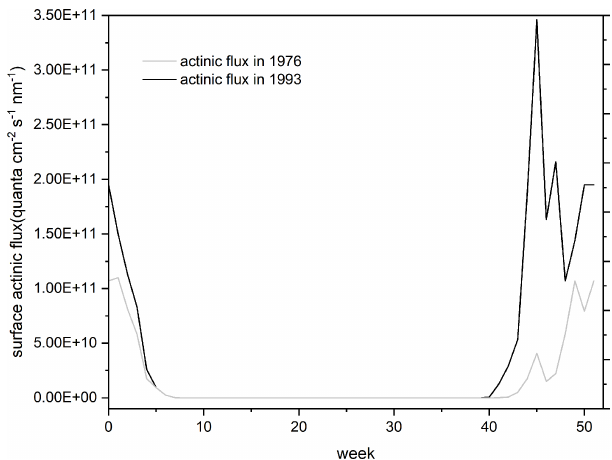
Figure 1. Surface actinic flux at a wavelength of 305nm (the peak wavelength of snow nitrate absorption spectra at the surface) in pre- ozone hole time (1976) and maximum ozone hole year (1993) at the South Pole. Results were calculated from the TUV radiation